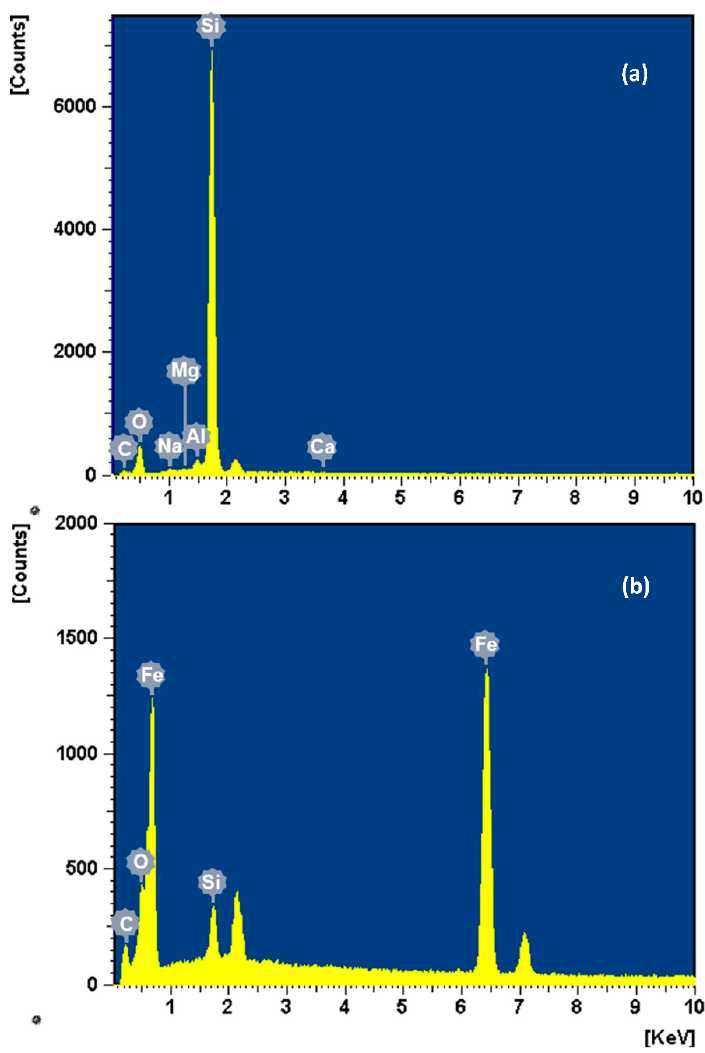
Figure 3. SEM with energy-dispersive X-ray spectroscopy (SEM-EDX) analysis of ( a ) Mt mineral and ( b ) Mt-nZVI heteroaggregate.